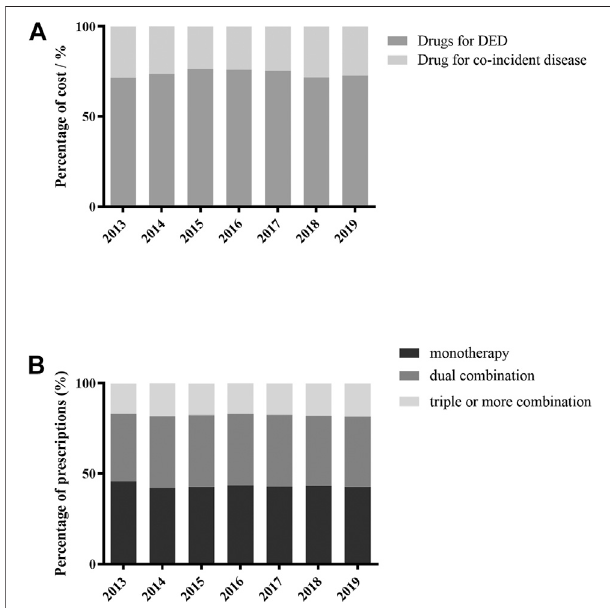
FIGURE 2 | Trends in drug classes for DED treatment. (A) Trends in the costs ofdrugsforthetreatment ofDEDand co-incident disease. (B) Trendsin patterns of DED topical treatment.